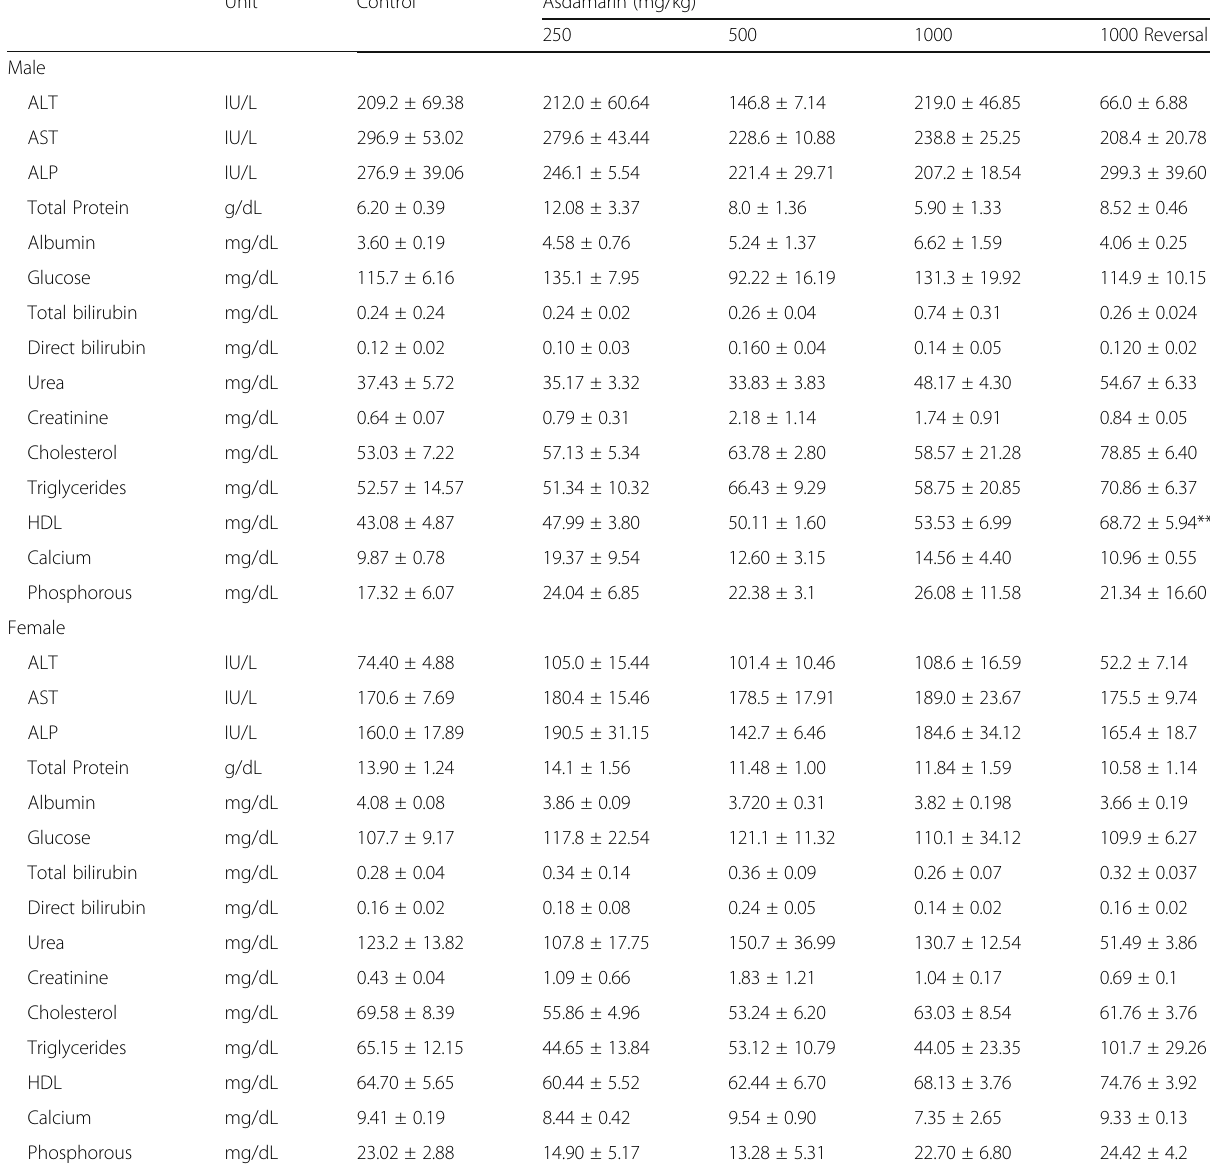
Table 5 Effect of Asdamarin on serum biochemical parameters in rats Unit